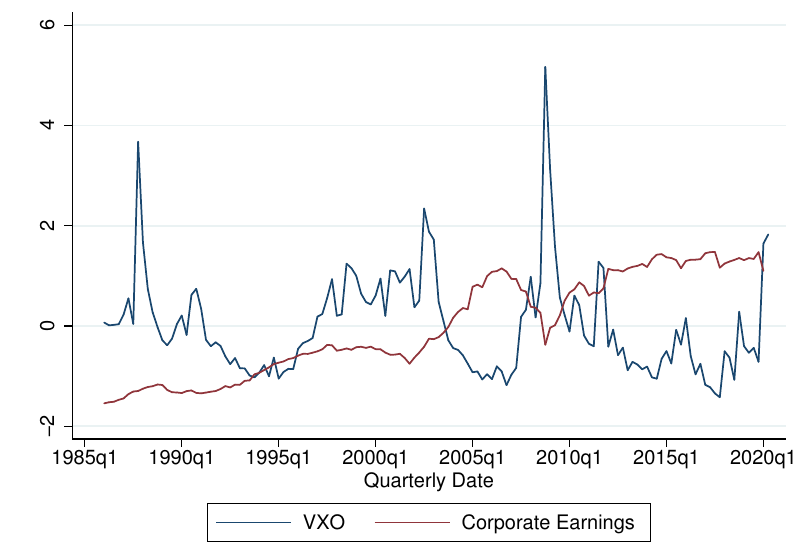
Figure A1. Corporate Earnings and the VXO. Notes : The figure shows the time-series of the corporate sector earnings along with the proxy of uncertainty. The figure suggests that corporate earning is procyclical while the uncertainty proxy is countercyclical. The correlation coefficients between the VXO and firms’ earning is − 0.30. Both series are